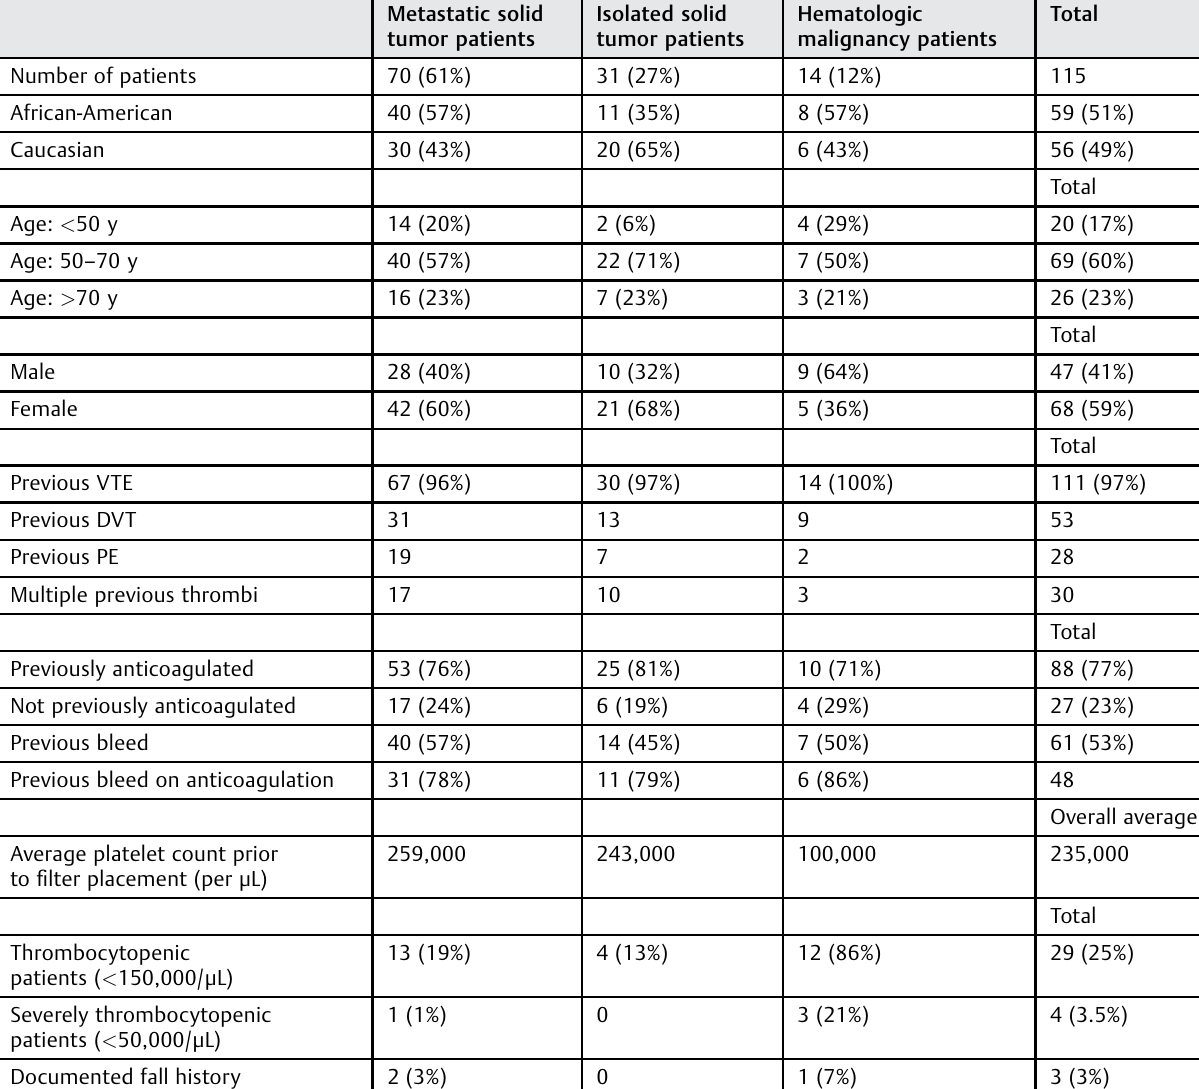
Table 1 Demographic data for patients in the initial cohort